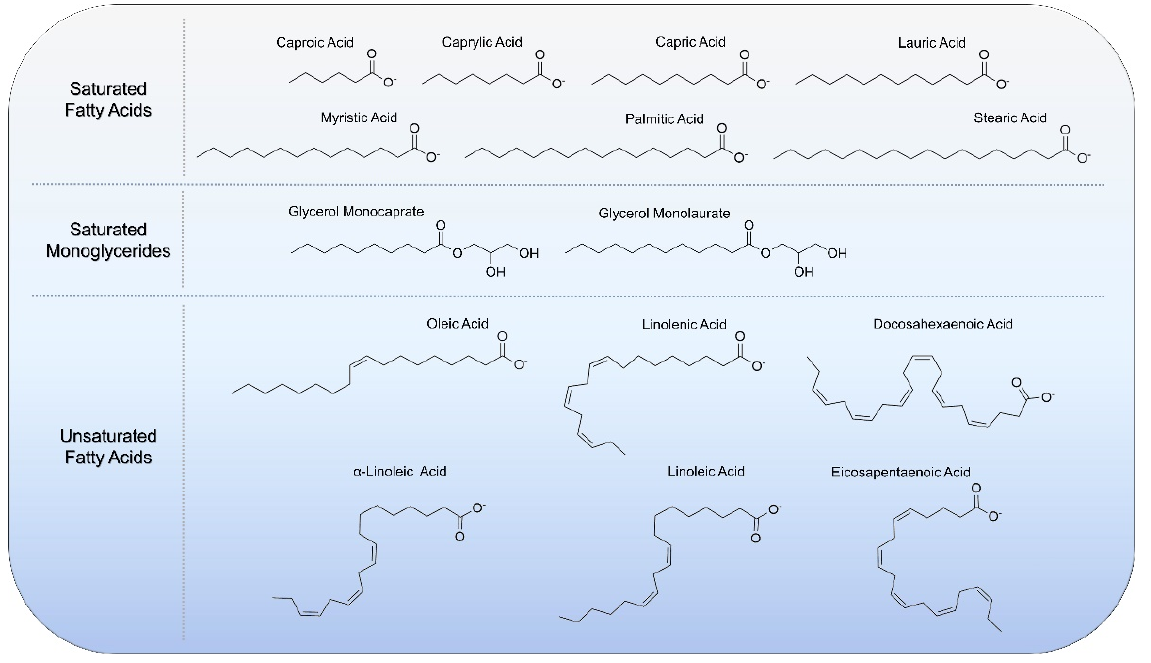
Figure 1. Molecular structures of biologically active fatty acids and monoglycerides that have been utilized with lipid nanoparticle technologies.